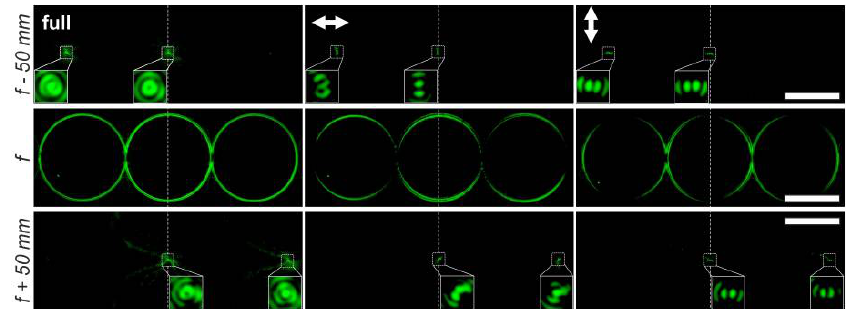
Figure 6. Experimentally obtained transverse component distributions of the focused azimuthally polarized laser beam passed through the fabricated DOE. The intensity distributions were formed in the focal plane of the lens L 4 . The white arrow shows the position of the axis of the polariz- er-analyzer. The scale bar is 1 mm.